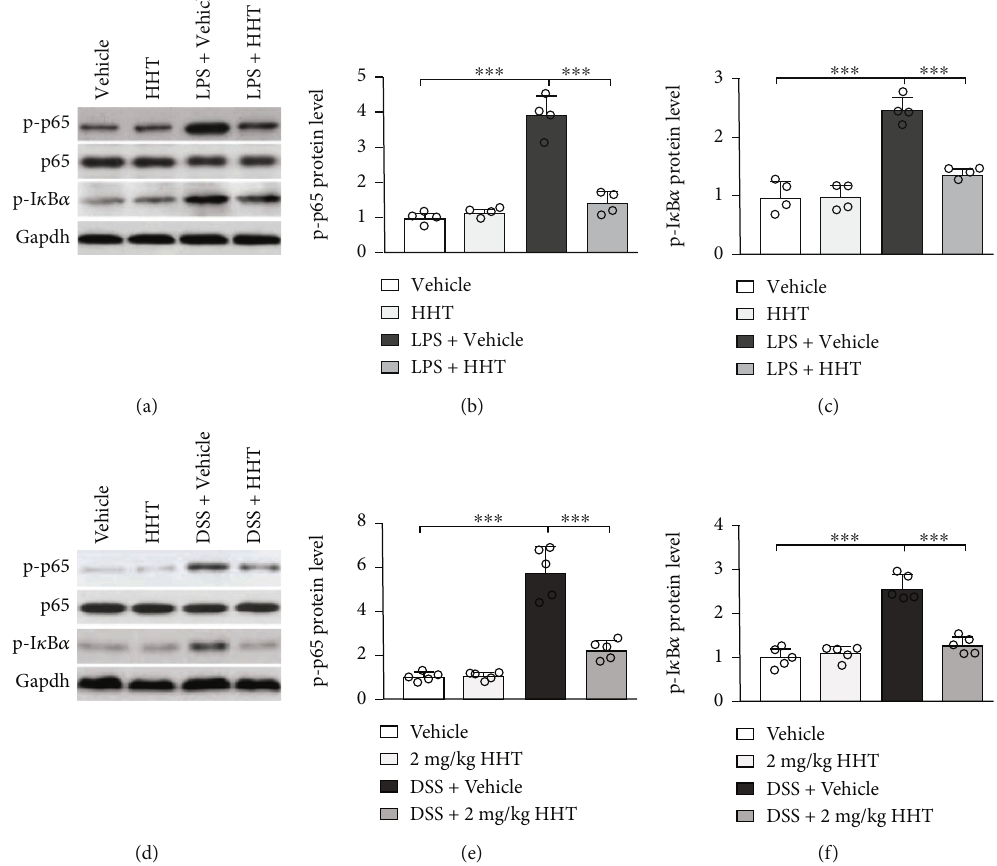
Figure 5: HHT reduces the activation of NF κ B signaling in vitro and in vivo . (a – c) Cultured RAW264.7 cells were stimulated with 1 μ g/mL LPS along with vehicle or 50 nM HHT for 1 hour. The level of p-p65 (a, b), p65 (a), and p-I κ B α (a, c) was analyzed by Western blot. (d – f) Mice were treated with 3% DSS along with vehicle or 2 mg/kg HHT for seven days, and the colon tissues were harvested to determine the protein level of p-p65 (d, e) and p-I κ B α (d, f) by Western blot. Five mice per group. Error bar represents mean ± SD . ∗∗∗ p < 0 : 001